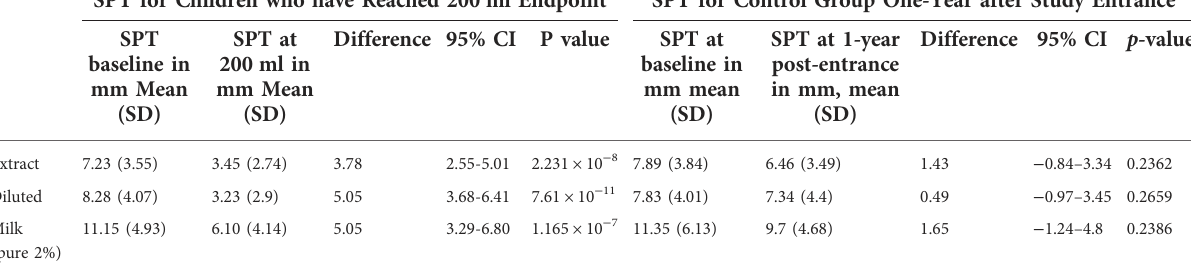
TABLE 2 SPT for children who have reached 200 ml endpoint vs. control group one-year after study entrance. SPT for Children who have Reached 200 ml Endpoint